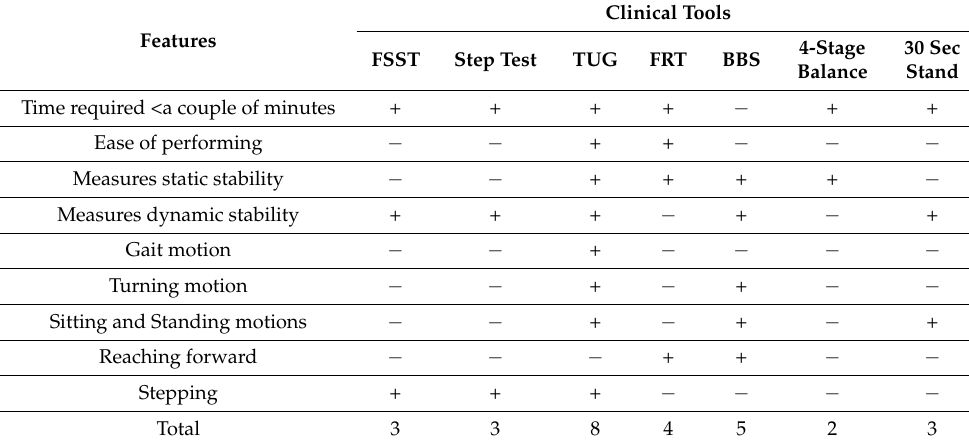
Table 1. Comparison of functional clinical fall-risk screening tests to find the simplest test with the most beneficial risk-factor measurement. +/ − denotes if a specific criterion is met in a clinical test. The total row counts the number of existing features for each